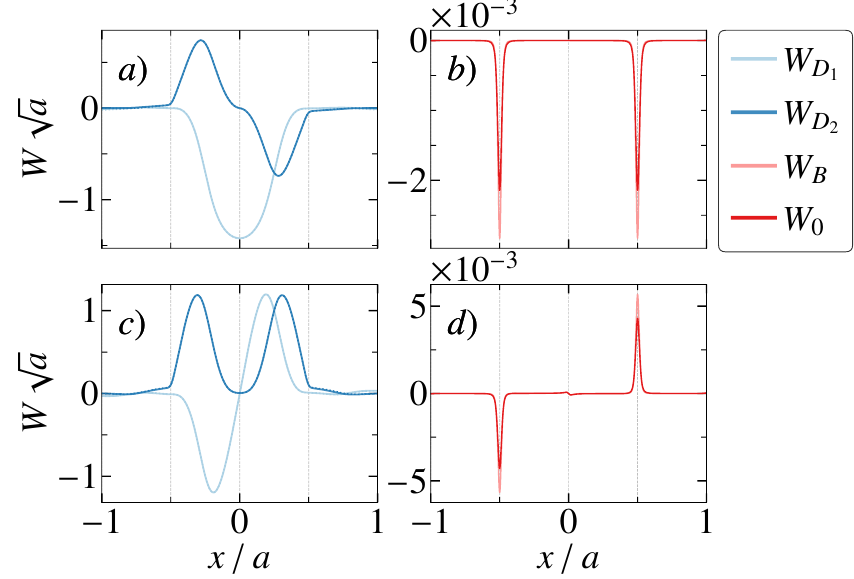
Figure 6: Exactly calculated Wannier functions centered at x = 0 for the dark states ( x ) in parts a) and c), as well as the bright state W W D 1,2